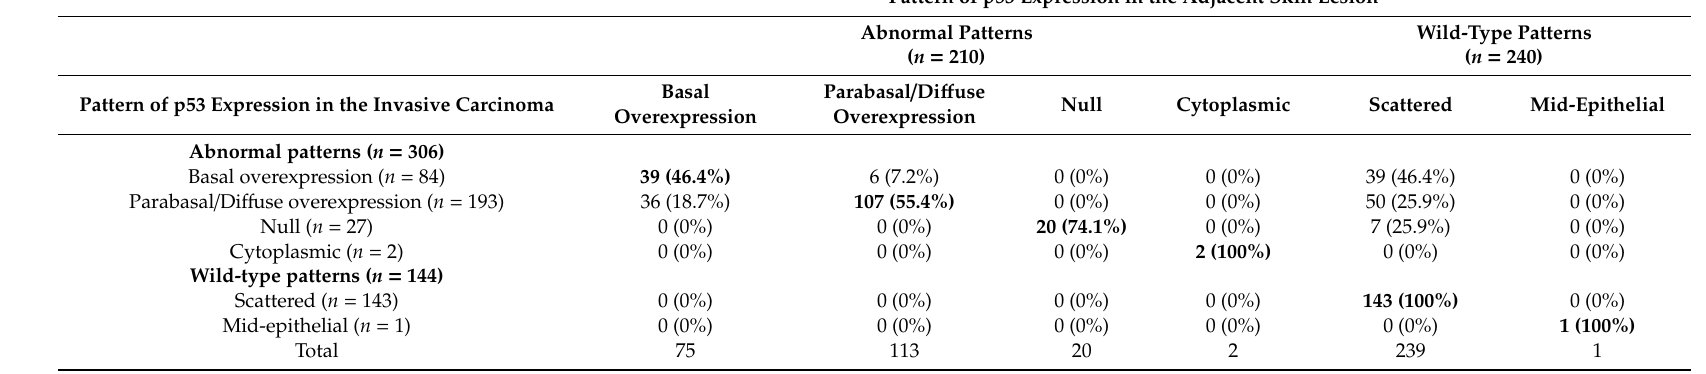
Table 2. Correlation of the p53 immunohistochemical patterns between the invasive squamous cell carcinoma of the vulva and the adjacent skin lesions in the 450 vulvar squamous cell carcinoma (VSCC) with abnormal skin. The cases in which the pattern of p53 expression in the invasive carcinoma and in the associated skin lesion is coincident are in bold and highlighted in grey (diagonal of